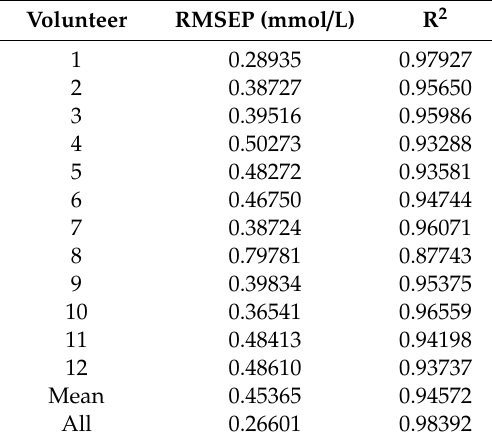
Table 2. RMSEP and R 2 for the 12